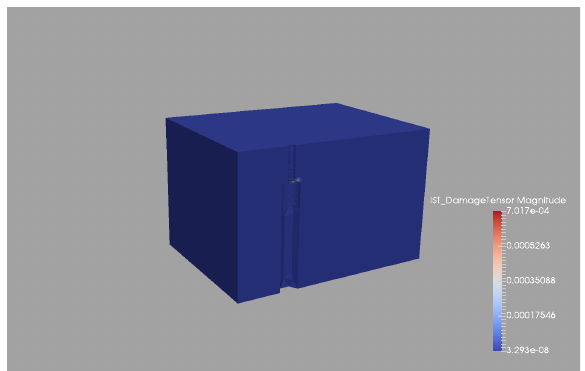
Figure 5. Anchor pullout test.